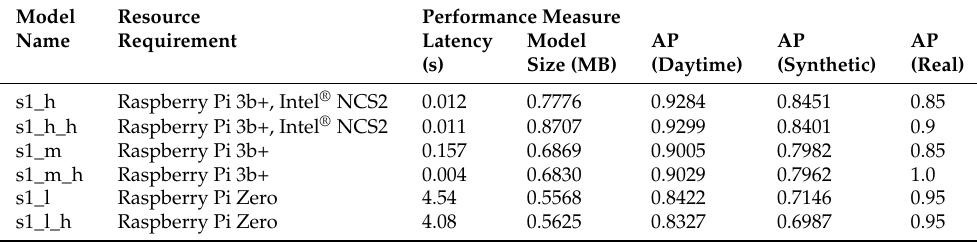
Table 5. Performance results of the detection